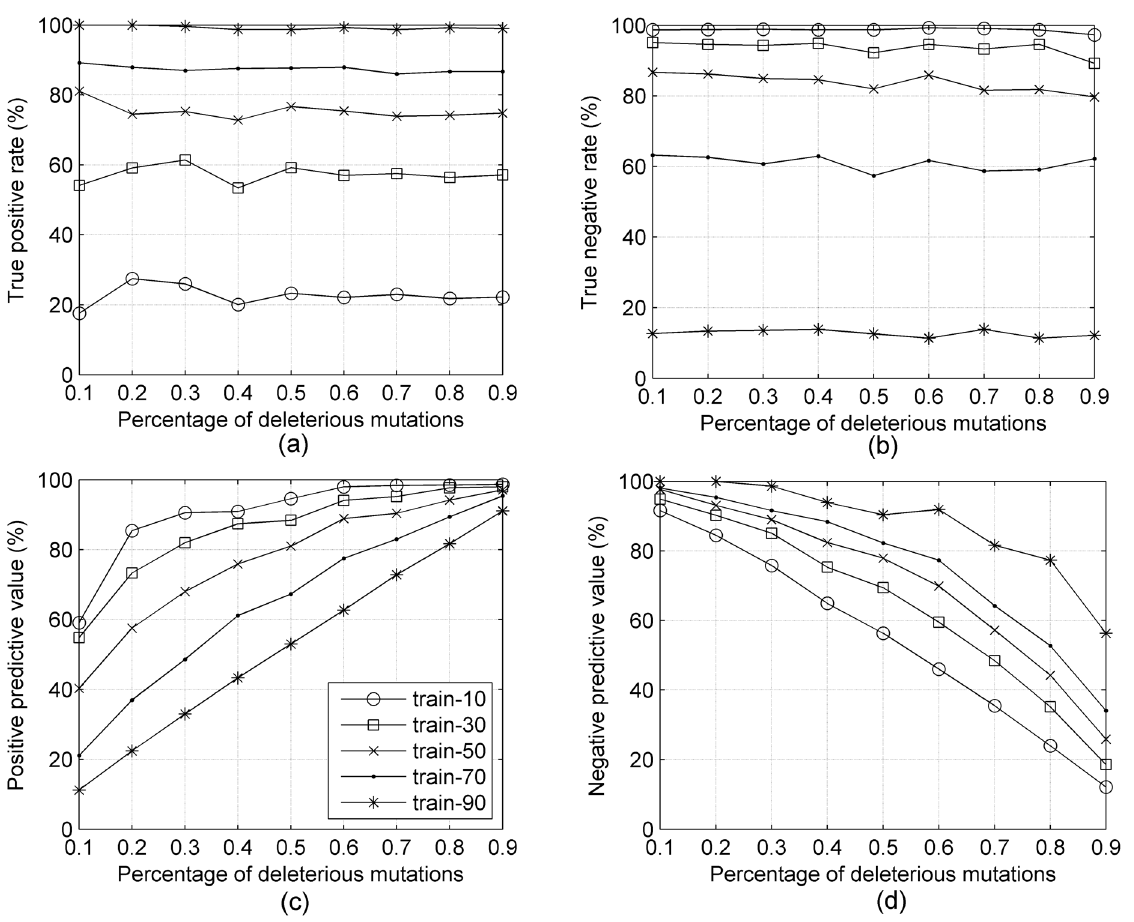
Figure 3. (a) TPR, (b) NPR, (c) PPV, and (d) NPV of five SVM models trained on 5 different data sets (train_10, train_30, train_50, train_70, and train_90) tested by 9 different testing data sets, ranging from 10% deleterious (x-axis=0.1) to 90% deleterious (x- axis=0.9).